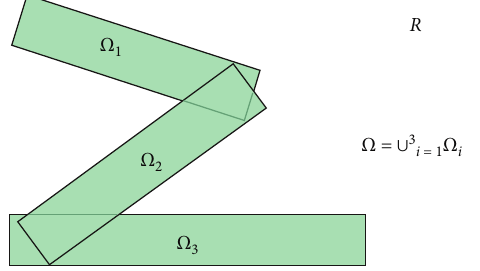
Figure 1: The geometry representation based on the MMC